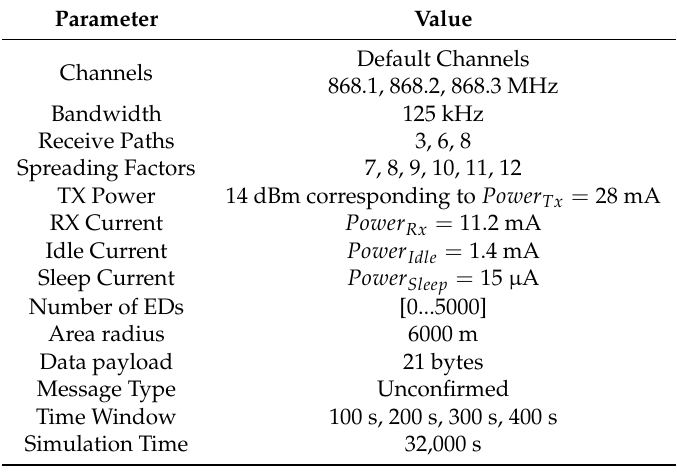
Table 8. Simulation